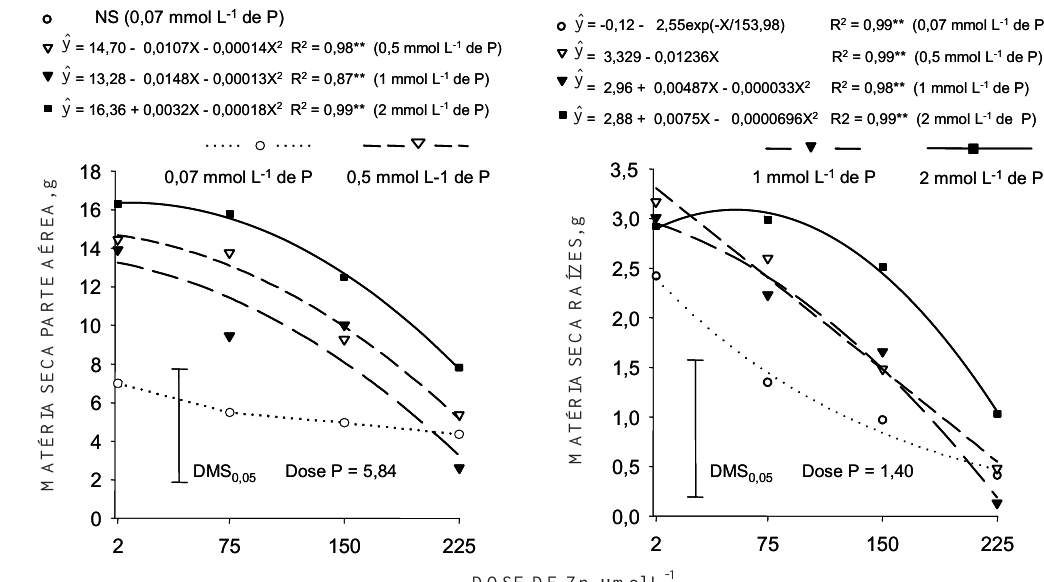
Figura 4. Matéria seca da parte aérea e raízes de mudas de Trema micrantha em resposta ao aumento de doses de Zn e aplicação de P em solução nutritiva (** P = 0,01; NS =